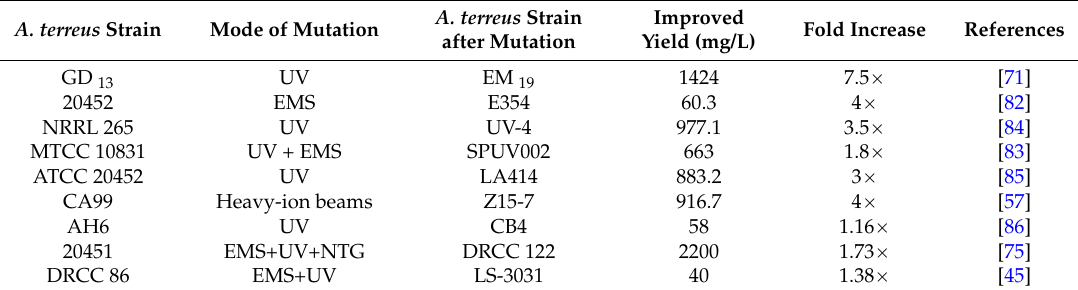
Table 4. Improved statin production through chemical and physical mutagenesis of A. terreus